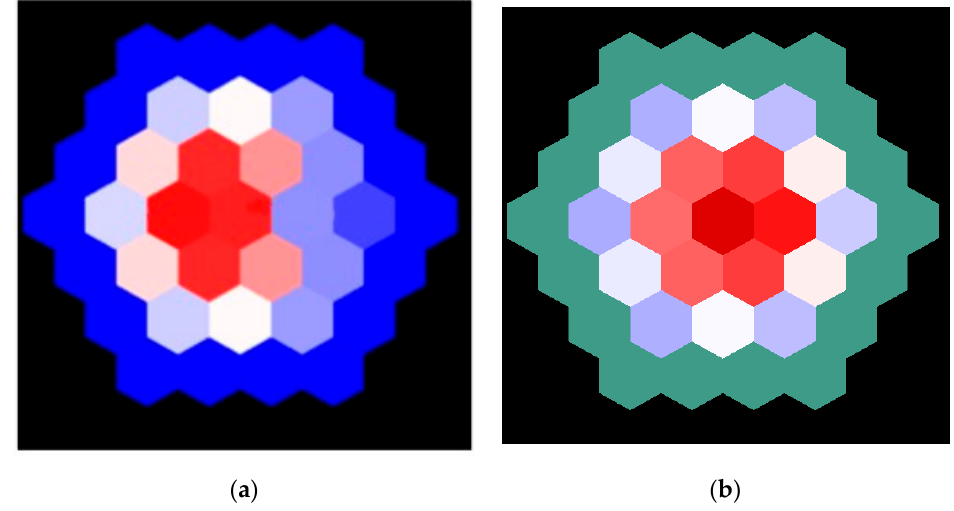
Figure 27. The 19 Hexagonal FA core case: ( a ) radial power distribution before transient; before transient; ( b ) power behavior during the transient; at the end of the transient.